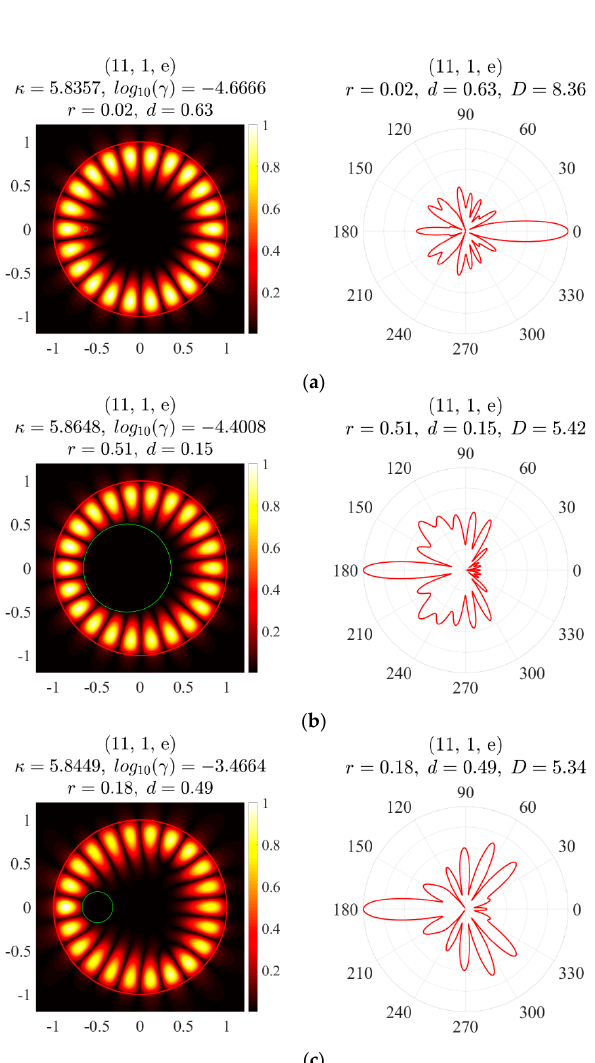
Figure 6. Near-field patterns ( left panels ) and far-field patterns ( right panels ) for even mode (11, 1), ( a ) 𝑟 = 0.02,𝑑 = 0.63 , ( b ) 𝑟 = 0.51,𝑑 = 0.15 , ( c ) 𝑟 = 0.18 , 𝑑 = 0.49 . Thus, in the course of the numerical experiments, we found that a quasi- unidirectional emission could occur both at a small hole radius and at a relatively large hole radius. In the case of a small hole radius, the main beam was directed oppositely to the direction of the hole shift, while in the case of a large hole, the main beam was in the same direction as the hole shift. The maximum directivity was obtained with a small relative radius of the piercing hole. These phenomena were studied by physical experiments in [22]. 5. Conclusions